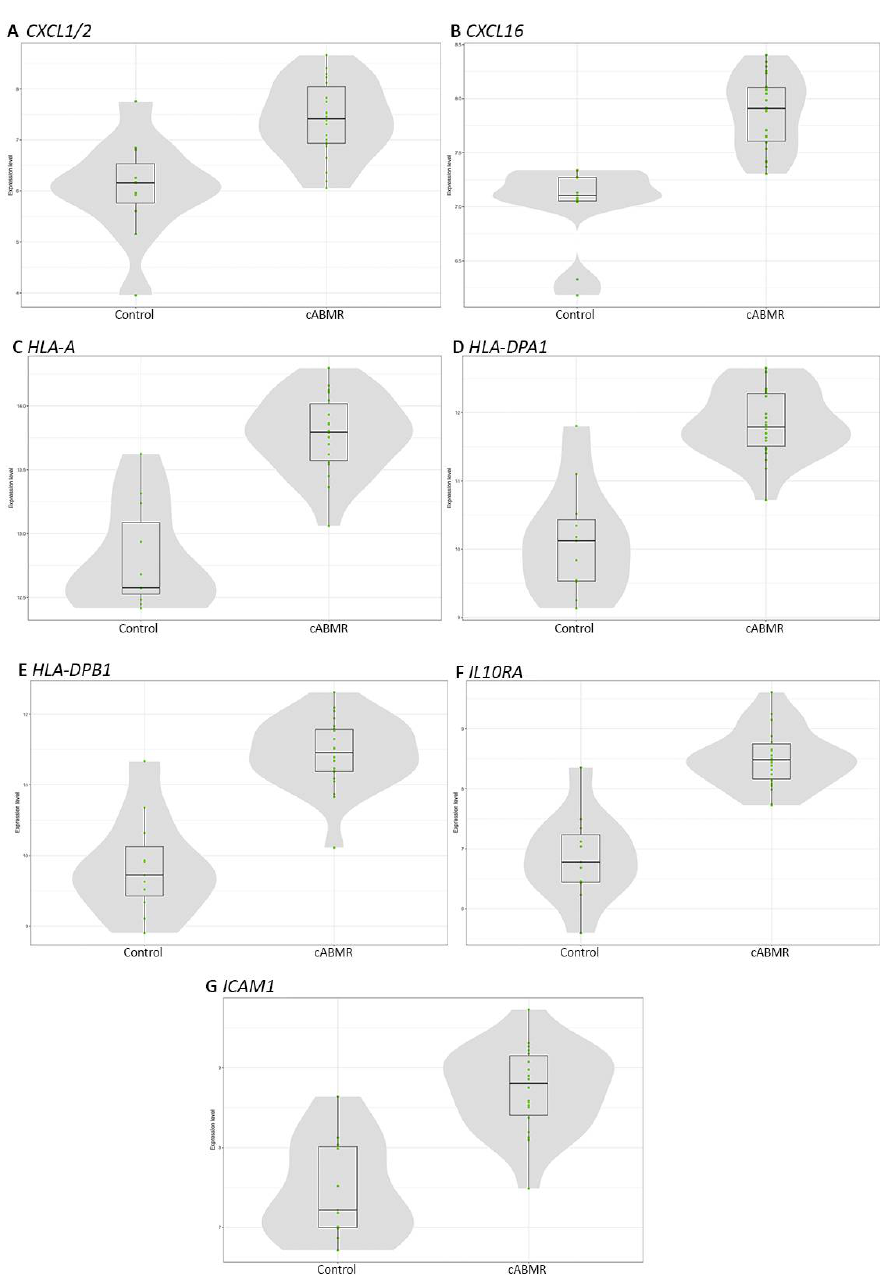
Figure 3. Box-plots of the most expressed genes in c-ABMR cases compared with the control group. CXCL1/2 ( A ) and CXCL16 ( B ) were among the genes most significantly expressed in c-ABMR, and they belonged to the CXCL family, a group of genes included in the chemokine signaling pathway. Similarly, HLA-A ( C ), HLA-DPA1 ( D ), and HLA-DPB1 ( E ) were part of the HLA group of genes with the most significant expression in c-ABMR. They were enlisted in several pathways including the adaptative immune system, the cell–ECM interaction, the MHC Class I Antigen Presentation, and the MHC Class II Antigen Presentation pathways. In addition, IL10RA ( F ) and ICAM1 ( G ) were also among the most significantly expressed genes in c-ABMR, and were included in the cytokine signaling and T-reg differentiation in the former, and in the adaptive immune system, cell–ECM interaction, cytotoxicity, lymphocyte trafficking, NF-kappa B signaling, TNF family signaling, and type II interferon signaling in the latter. The grey areas represent the estimated genes’ expression distribution, while the green dots represent sample log2 expression for each